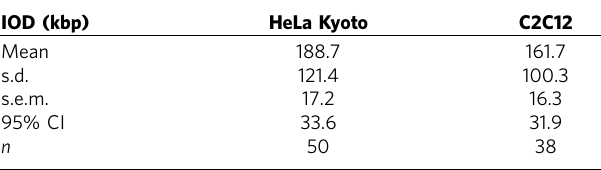
Table 3 | Statistics of the IOD measurements. Table 4 | Statistics of the RFS